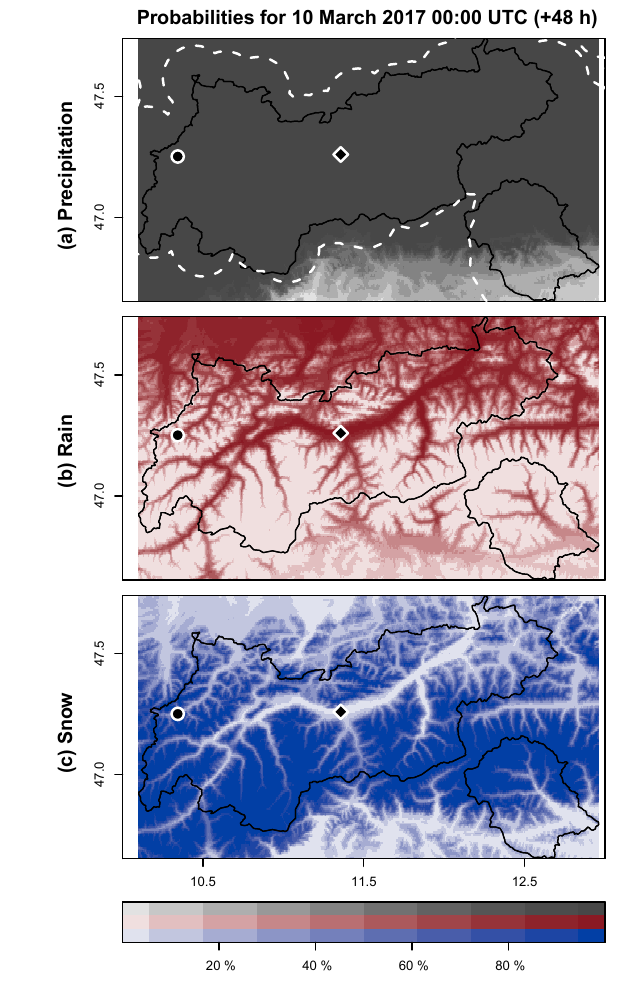
Figure 10. Top–down: 1h probability of precipitation (rain ∨ snow), rain, and snow for 10 March 2017 00:00UTC ( + 48h forecast initialized 8 March 2017). Overlays: the govern- mental area of Tyrol (solid line), Innsbruck Airport (diamond), and the location of the example station used in Fig. 9 (circle). The white dashed line outlines the area not further away than 10km from the closest measurement site.